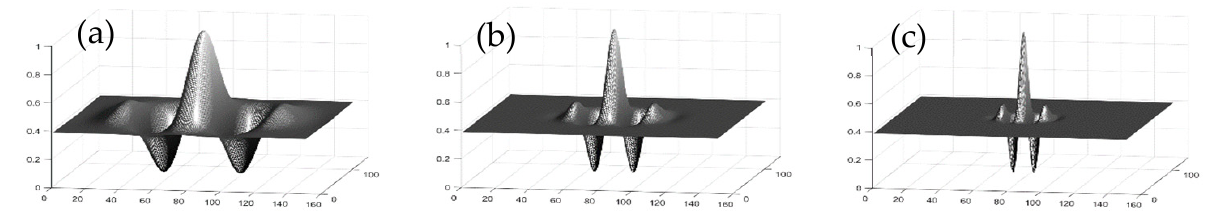
Figure 4. 3D representation of 2D Gabor filter kernels (real part representation) of various wavelengths (or spatial frequencies/scales) representing ( a ) low-frequency, ( b ) mid–frequency, and ( c ) high-frequency wave patterns. These filters can also be rotated.